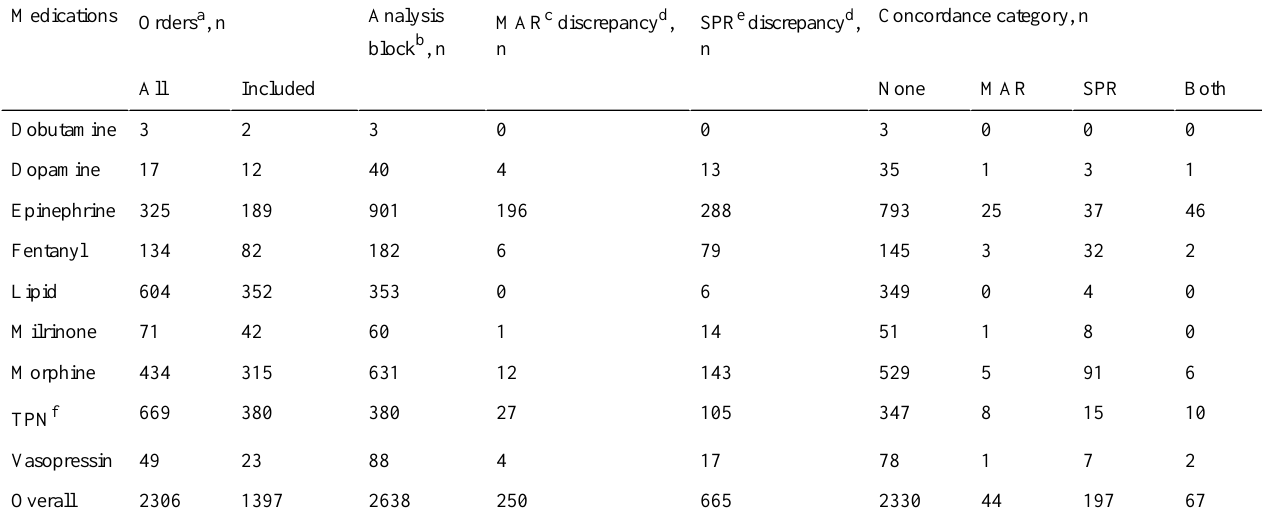
Table 5. Concordance assessment between medication administration record and smart pump record